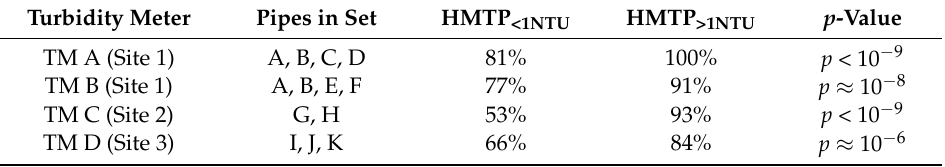
Table 3. Hydraulically Mobilised Turbidity Percentage (HMTP) carried out on each pipe in series between the upstream sources and downstream service reservoirs to assess the amount of